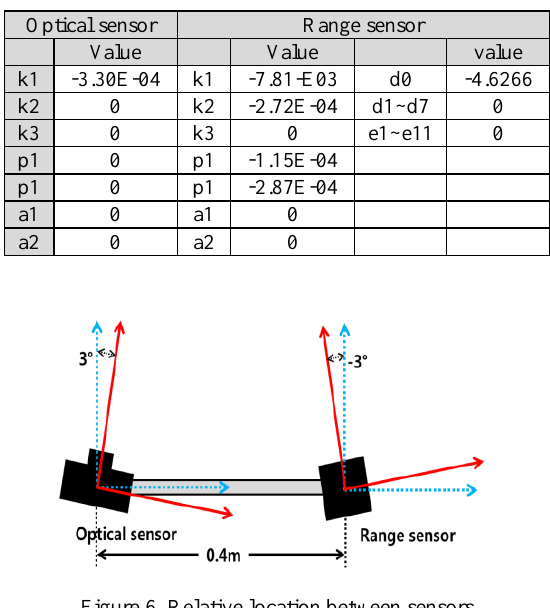
Figure 6. Relative location between sensors Table 5. Relative orientation parameters of range sensor